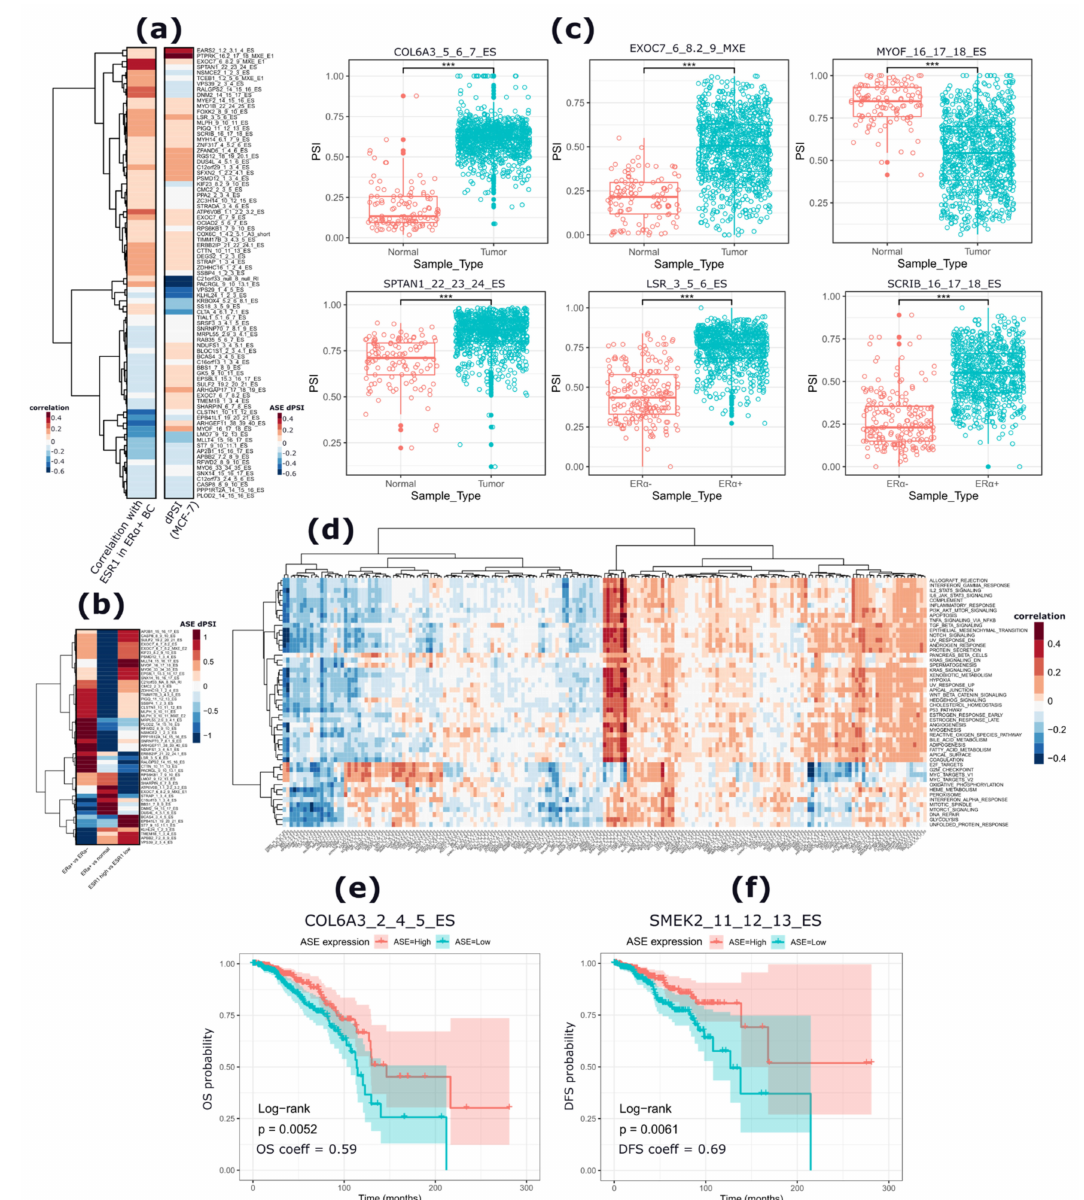
Figure 4. Analysis of the apoER α -regulated ASEs in normal and BC tissues. ( a ) Heat map reporting the dPSI levels in MCF-7 and the correlation coefficient of the ASEs expression (PSI value) with ESR1 expression in ER α + BC samples from the BRCA TCGASpliceSeq database. The ASEs are labeled as their gene name, exons involved in the event (regulated and flanking exons), and the type of event. ( b ) Heat map reporting dPSI values of ASEs compared among (i) ER α + vs. ER α -, (ii) ER α + vs. normal, and (iii) high ESR1 vs. low ESR1 expressing patients. The plot reports 51 ASEs which were significant ( p < 0.05) in all comparisons. ( c ) Box plots reporting the PSI values of selected ASEs whose inclusion levels are different among compared groups (tumor vs. normal) and (ER α + vs. ER α -) patients. Wilcoxon p -value (***, p < 0.00001). ( d ) Heat map representing the correlation of ASE PSI values of ER α -regulated ASEs with enriched hallmarks as reported using PEGASAS algorithm [35]. ( e , f ) Survival analysis plots showing the top significant ASE associated with overall survival (OS) ( e ) and disease-free (DFS) survival ( f ) of Er α + BC patients. Patients are divided into a high expression (ASE = high) and a low expression event (ASE = low) based on the median PSI calculated among all